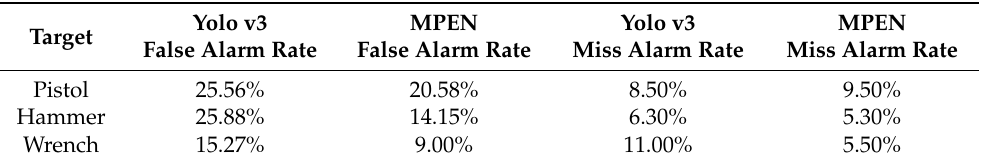
Table 3. Comparison of false alarm rate and miss alarm